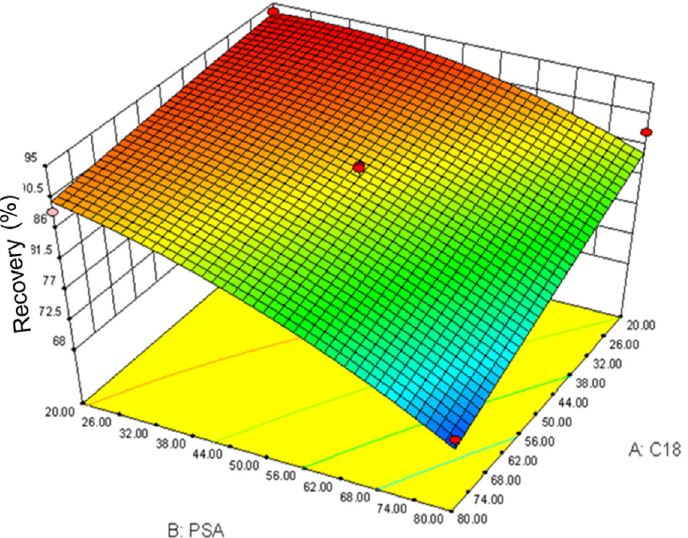
Figure 4. The three-dimensional overall desirability response surface plot for the PSA and C 18 factors under the CCD test.